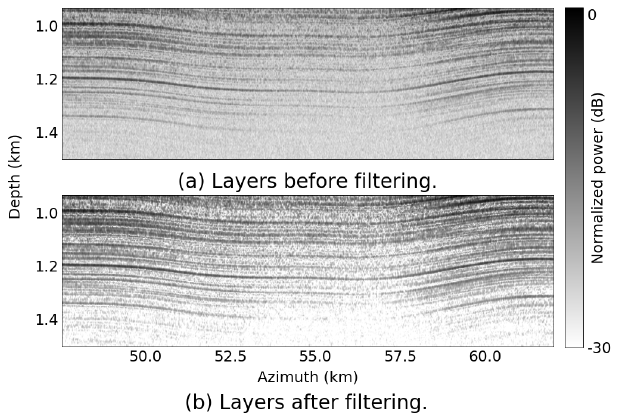
Figure 8. Improvement of internal-layer visibility for track 1. The subsets of the SAR echogram before and after the processing are shown at the top and the bottom correspondingly. malized prior to the comparison.